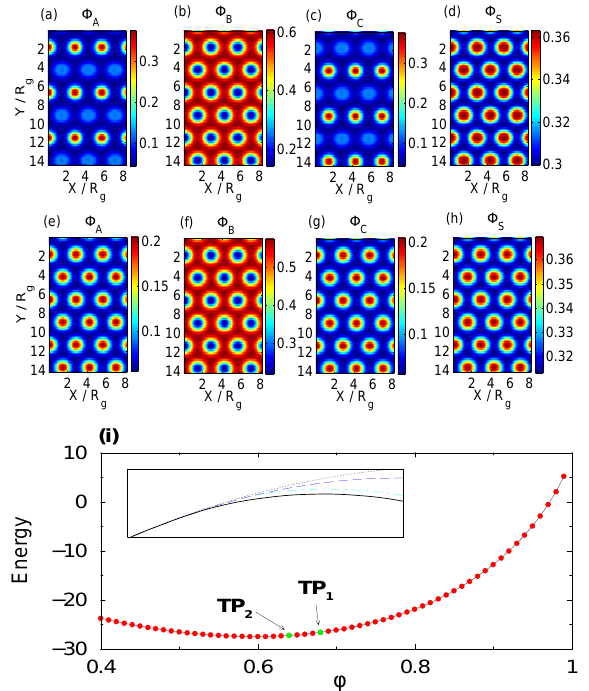
Figure 4. (a), (b), (c) and (d) show spatial monomer densities of the A, B, and C components of the polymer as well as the solvent density for polymer volume fraction φ = 0 . 68 , χ N = AB χ N = χ N = 50 , χ N = χ N = 5 and χ N = 30 . (e), (f), (g) and (h) show AC BC AS BS CS the concentration of the A, B and C components of the polymer as well as the solvent for polymer volume fraction φ = 0 . 67 (the Flory-Huggins parameters are the same). (i) Free energy of the melt (dimensionless units) as a function of the polymer volume fraction φ . The transition points (TP ) and (TP ) are marked on the figure. The inset shows the free energies 1 2 of the disordered phase (short-dashed line), the lamellar phase (short-dashed/long-dashed line) and the hexagonal phase in which A and C components mix (long-dashed line) in the neighborhood of TP 2